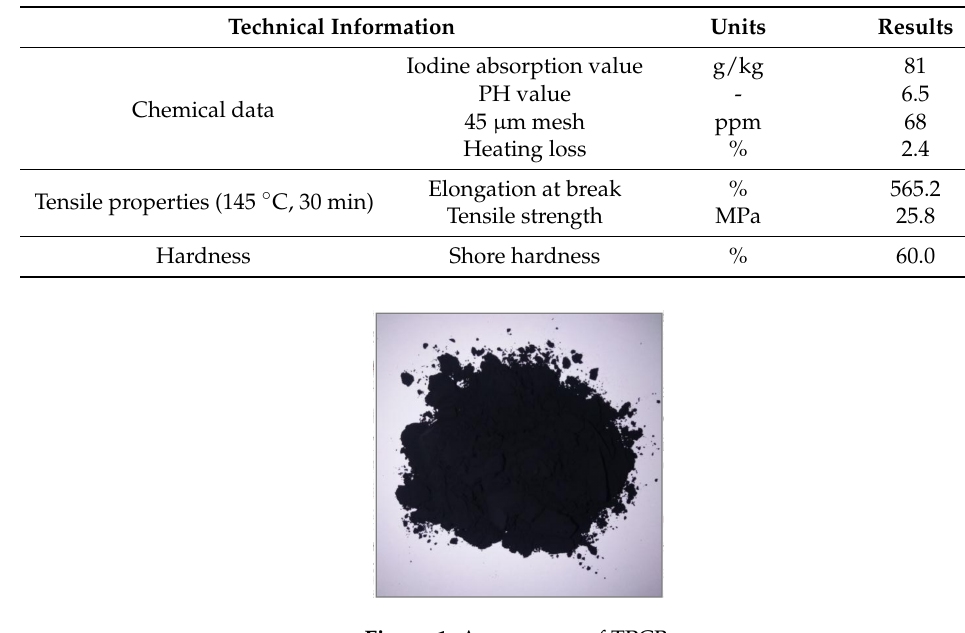
Figure 1. Appearance of